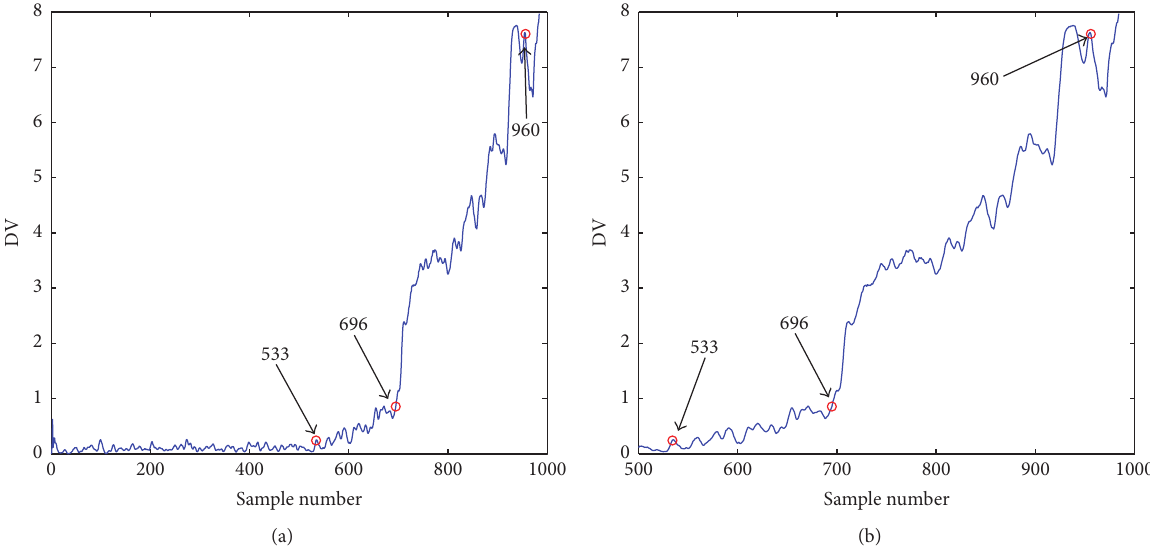
Figure 7: Assessment result using LWPSE and SVDD. (a) Life-cycle assessment result of bearing 1. (b) Local enlargement of